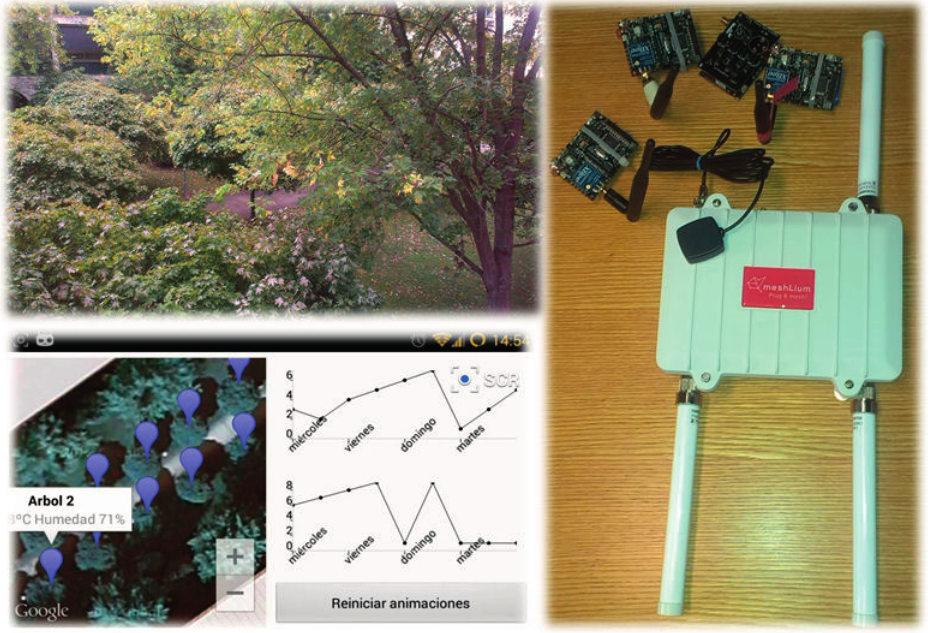
Figure 19. Experimental scenario ( left top ), application ( bottom left ) and devices of the WSN ( right